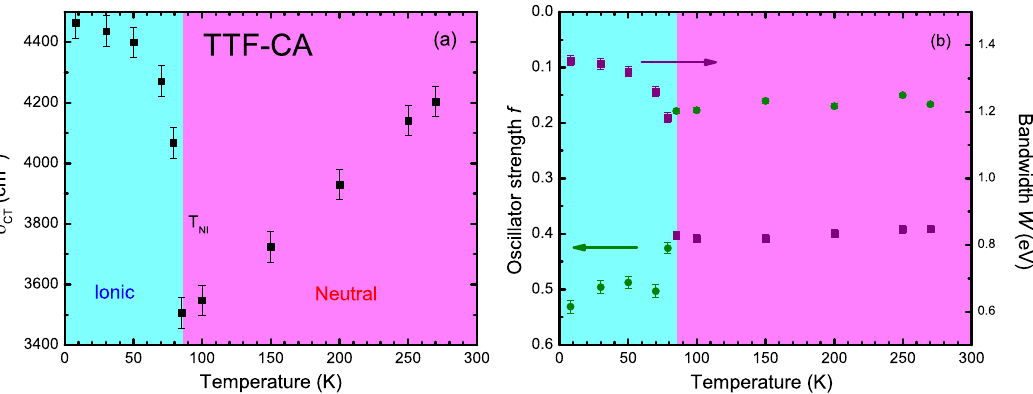
Figure 17. ( a ) Resonance frequency of the charge-transfer band of TTF-CA as a function of temperature; ( b ) Temperature dependence of the oscillator strength of the charge-transfer band (left scale) and the bandwidth for different temperatures (right scale).